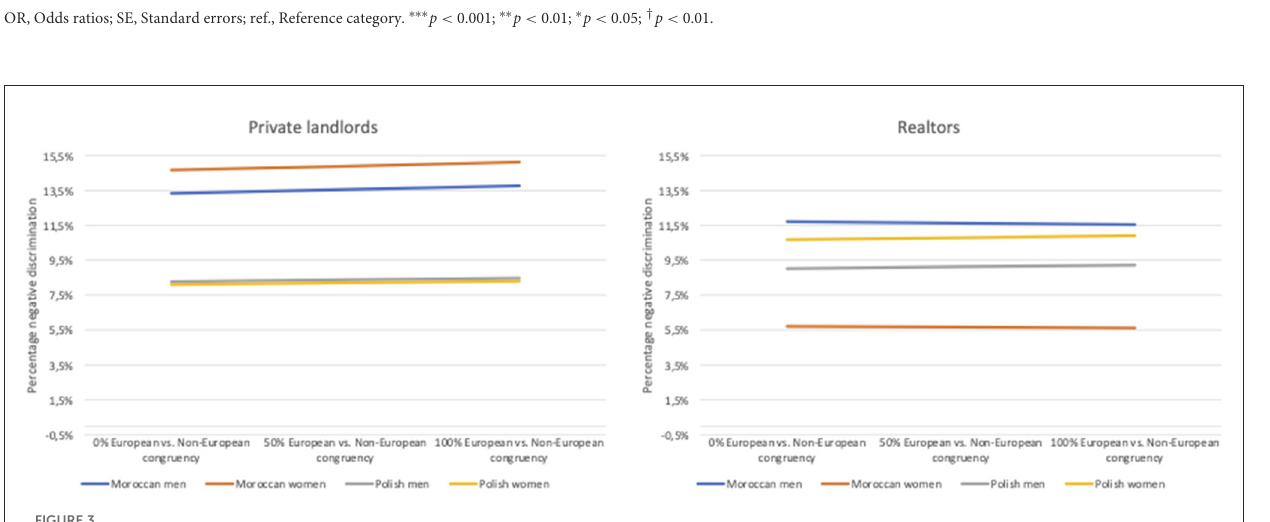
candidates with Arab/Muslim names as compared to other ethnic minority